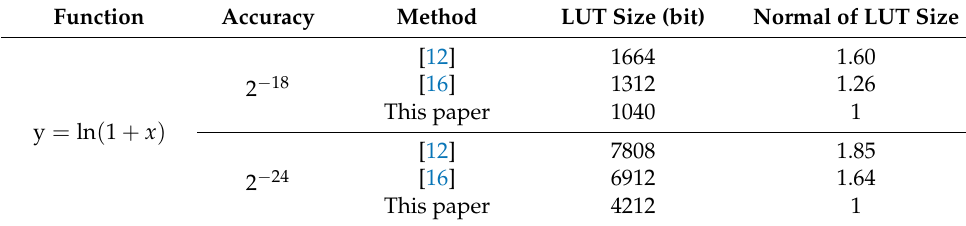
Table 5. Comparison in LUT